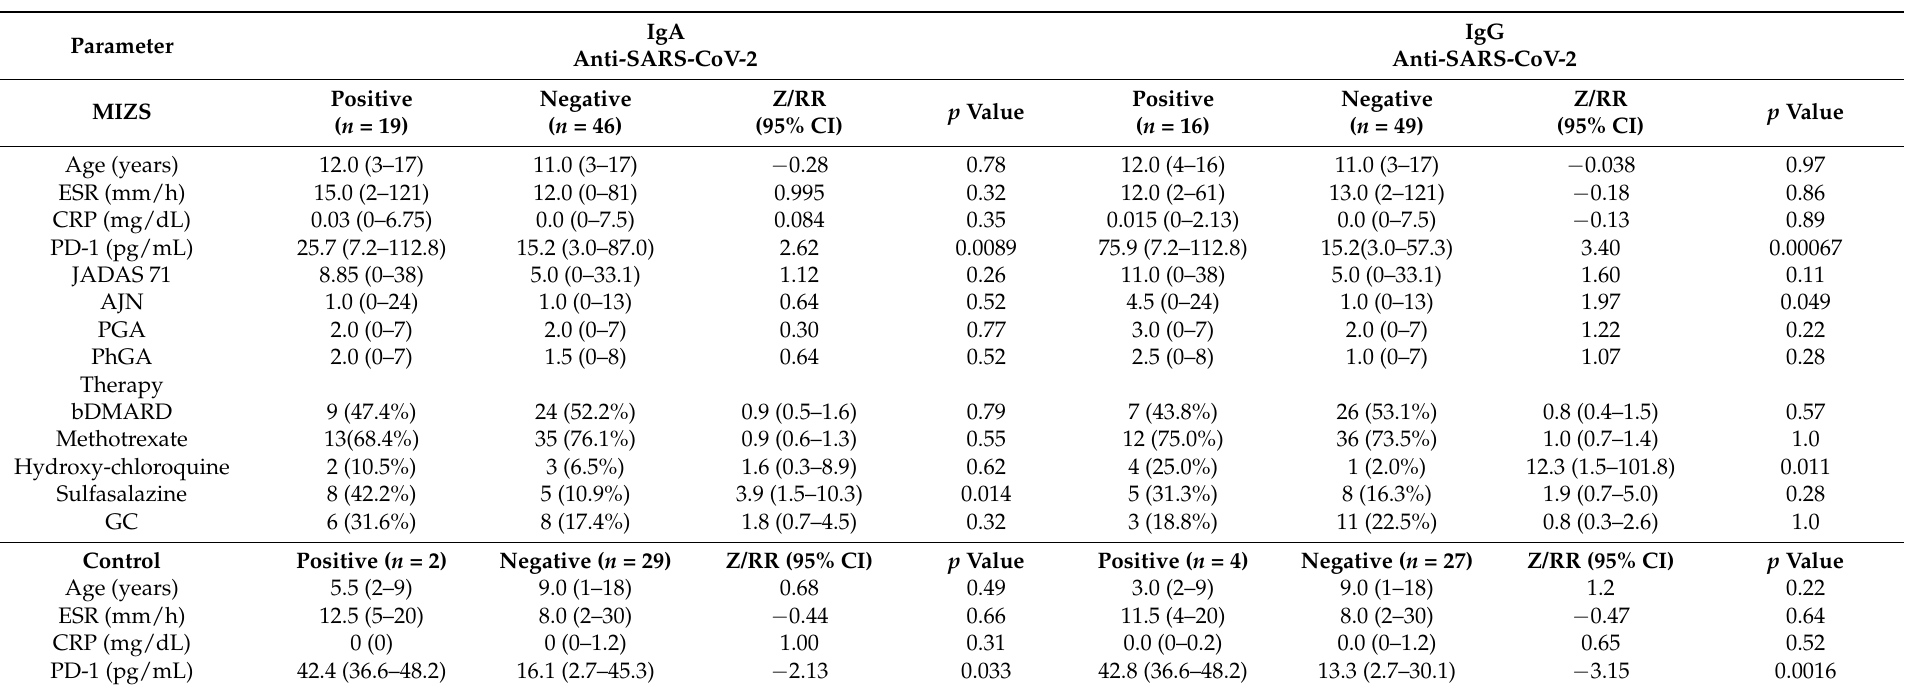
Table 3. Parameters of JIA patients and control dependence on the result of anti-SARS-CoV-2 antibodies (seropositive versus